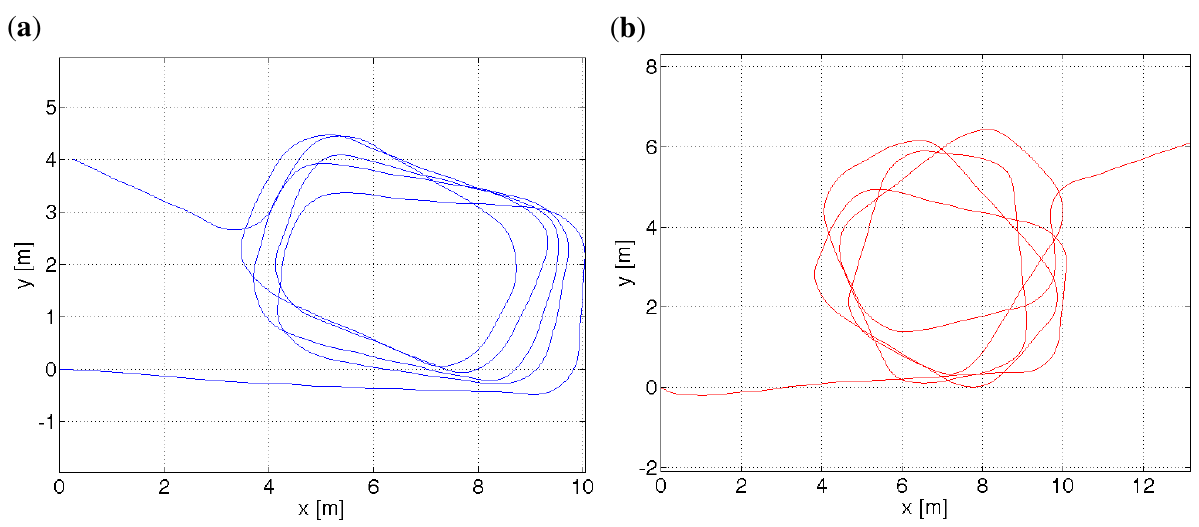
( a ) Path plotted for the pedometer and gyroscope readouts. The gyroscope readouts are corrected by the gravity estimation algorithm. ( b ) Path with no gyroscope correction. Points ( x, y ) = (0 , 0) denote the starting point. There were 20 turns, each 90 ◦ . The trial was started and ended in the same point. The difference between the heading direction at the beginning and at the end was ≈ 21 ◦ , which corresponds to 1 ◦ of error per every